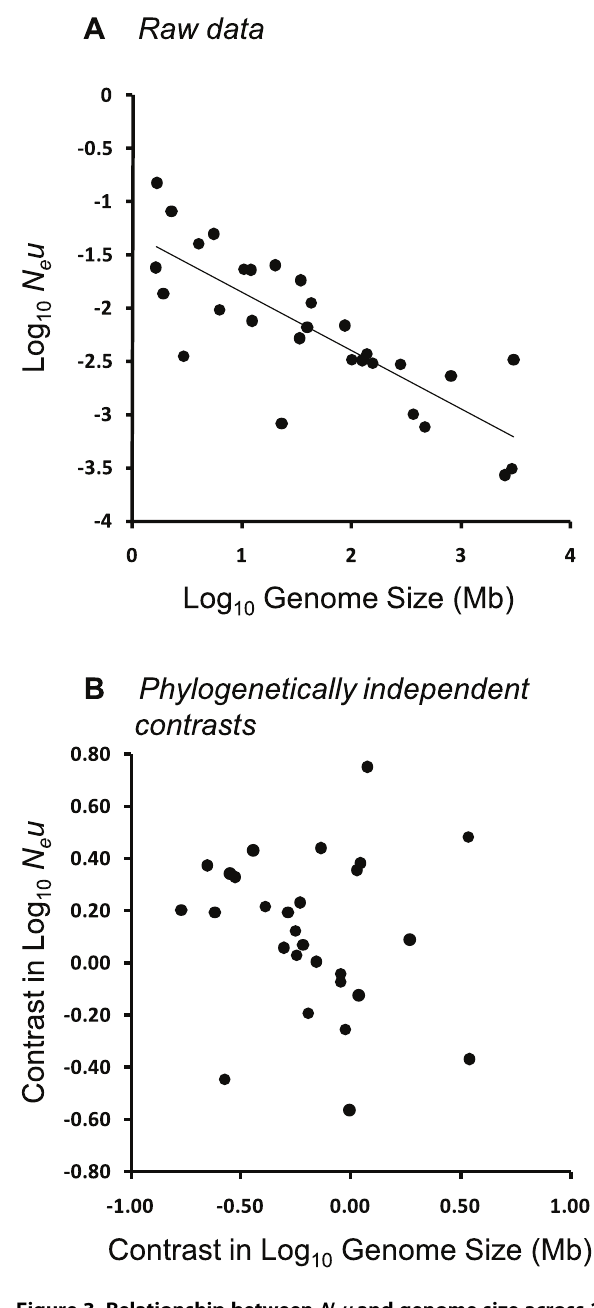
Figure 3. Relationship between N e u and genome size across 22 eukaryotic and 7 prokaryotic species from the dataset of Lynch & Conery [ 7 ] . (A) Ordinary least squares regression (OLS); r 2 =0.64, P , 0.0001. (B) Standardized phylogenetically independent contrasts (equivalent to PGLS) using branch lengths of 1.0; r 2 =0.08, P =0.138. Values have been ‘‘positivized’’ on the x-axis